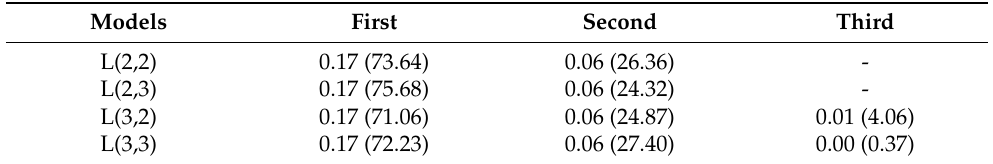
Table 3. Eigenvalues of the additive genetic (co)variance matrix and the proportion of total variance (%) estimated from the Legendre models.